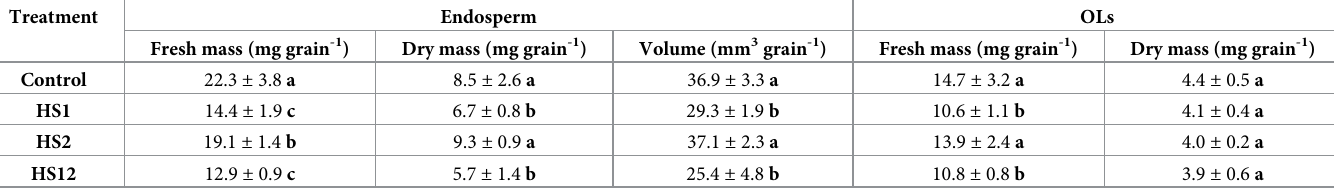
Wheat plants exposed to heat shocks during the lag-phase (HS1), the filling-phase (HS2) or both phases (HS12). For OLs, it was not possible to measure the volume as grains were dissected. The end of the lag-phase was estimated as the end of endosperm cell multiplication ( i . e ., 220˚Cd for C and HS2 treatments and 186˚Cd for HS1 and HS12 treatments). Data are means ± 1SD (n = 5). Within each column for a given developmental stage, means followed by different letters were different at a 5% level of significance (SNK